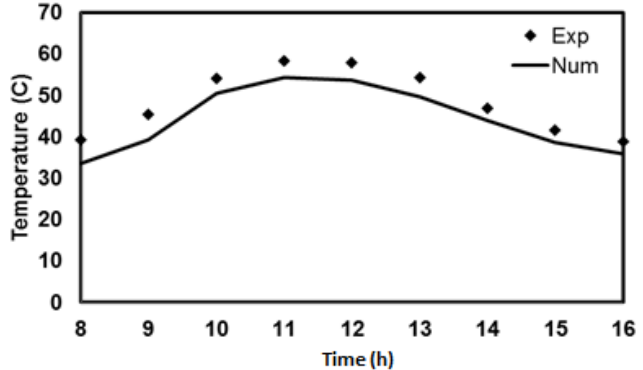
Figure 22. Comparison of cell temperature by numerical and experimental